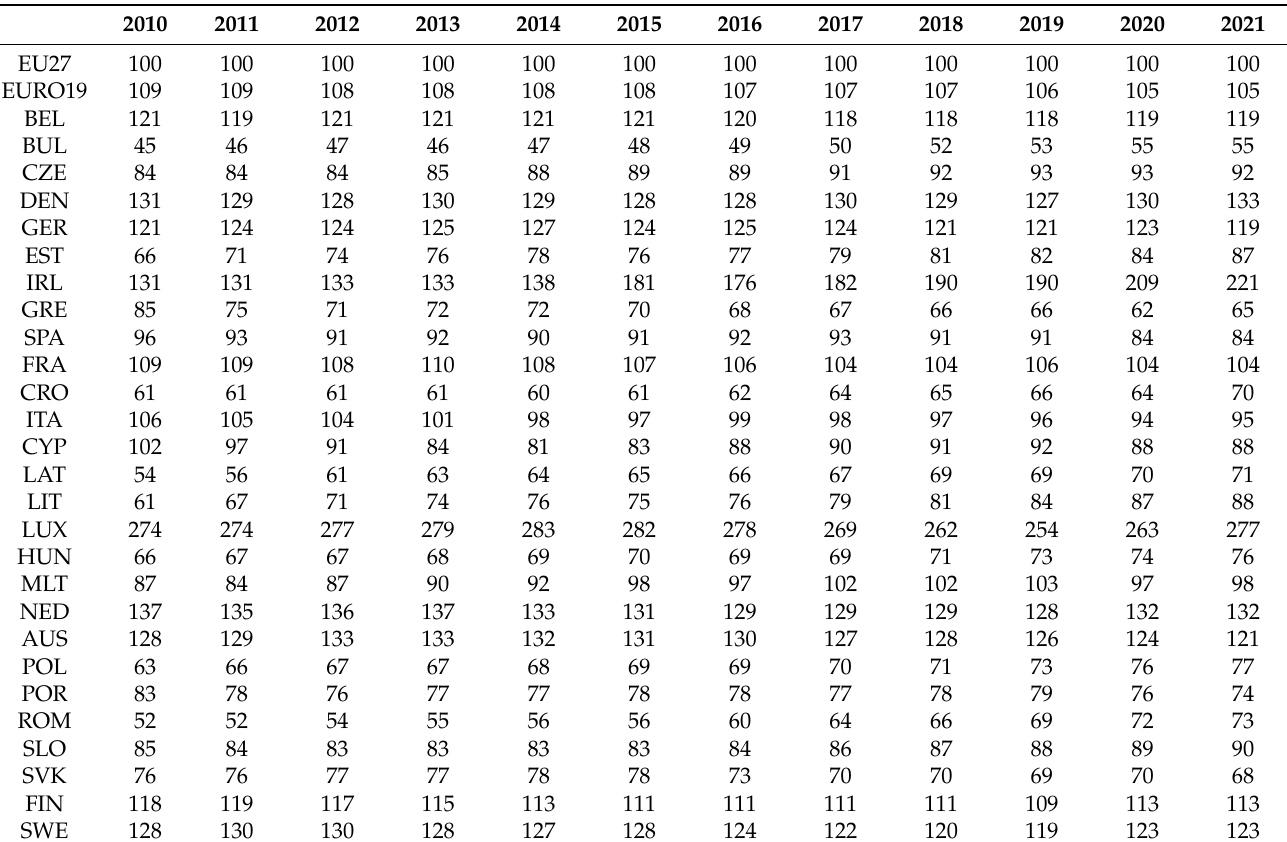
Table 1. HDP per capita PPP EU27